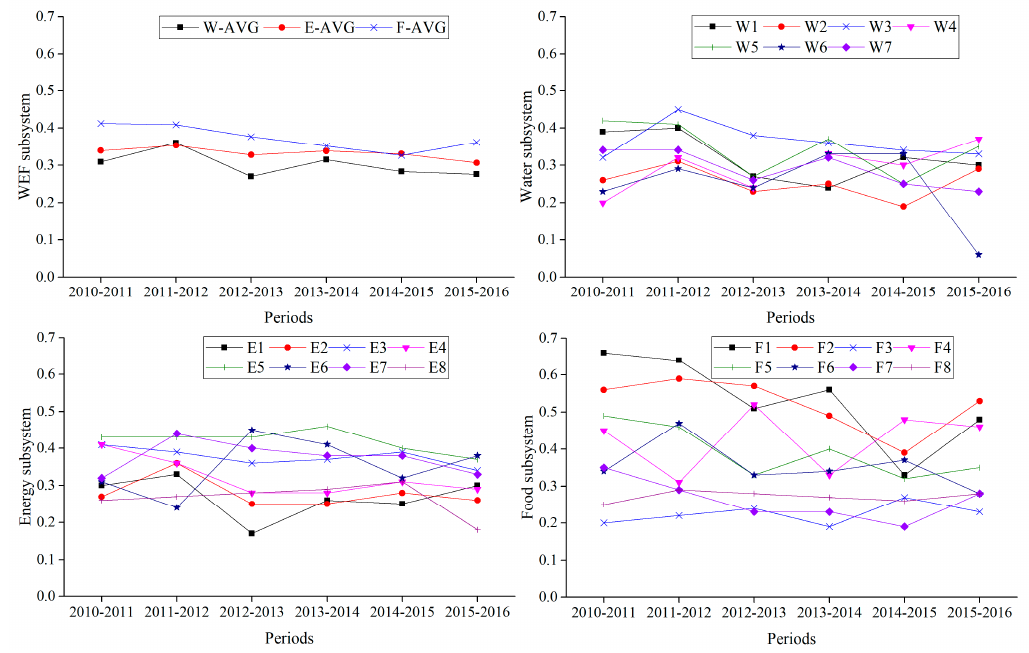
Figure 2. The mean value of synergy degree of 23 order parameters in six periods.